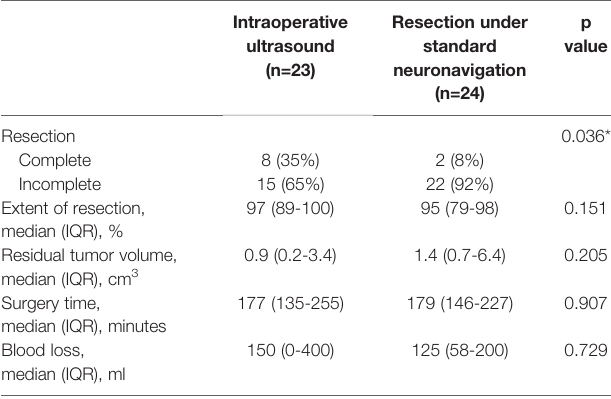
TABLE 2 | Surgery